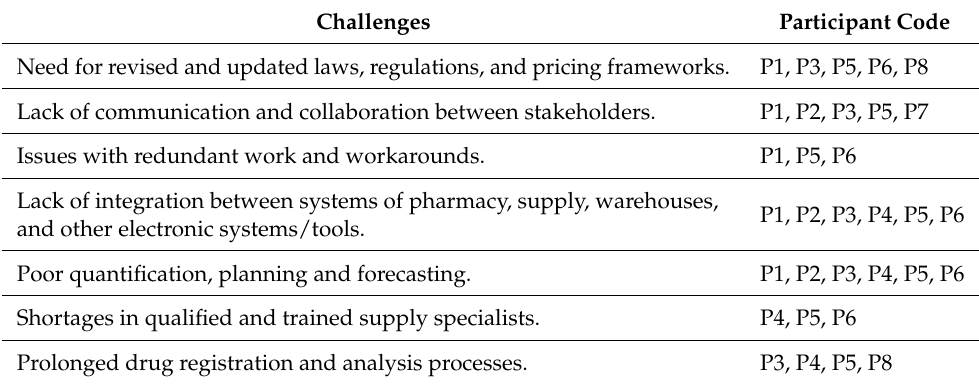
Table 4. Summary of the procurement and resource allocation challenges. Challenges Participant